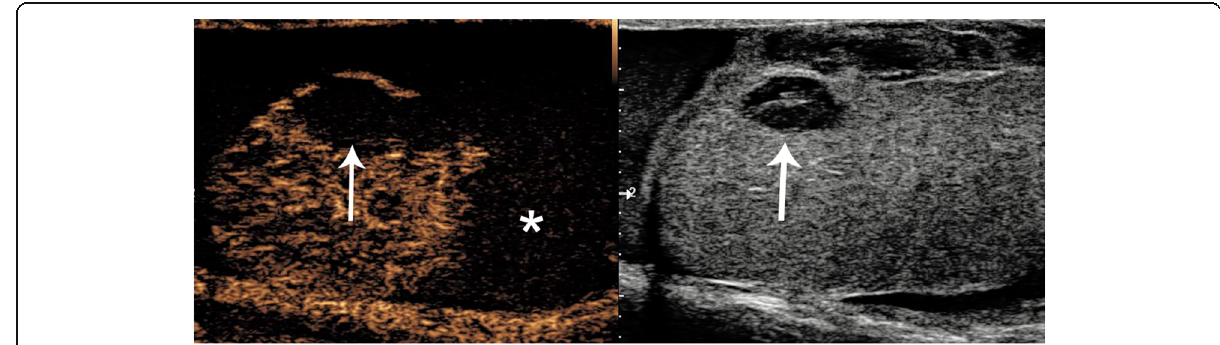
Fig. 3 CEUS appearances of haematoma and ischaemia after blunt trauma. Dual-display image showing contrast-specific (left) and low MI B- mode image (right). A rounded hypoechoic and well-circumscribed lesion is seen (arrow), which shows no enhancement, in keeping with an intratesticular haematoma. Importantly, the lower pole of the testis appears heterogeneous on B-mode and shows no enhancement on CEUS, indicating the diagnosis of ischaemia (asterisk). The changes of the area of ischaemia are subtle on the B-mode image alone. Note the ability of CEUS to clearly define the borders of infarction which may be obscure on B-mode imaging